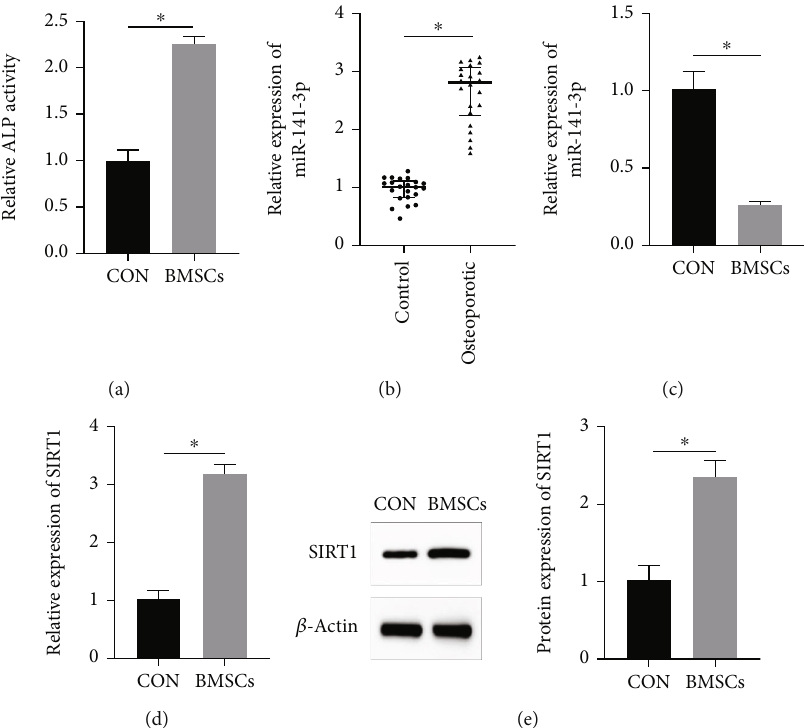
Figure 1: miR-141-3p was downregulated during osteogenic di ff erentiation. (a) ALP activities were evaluated by spectrophotometry. (b, c) The miR-141-3p expression in osteoporotic samples (b) and BMSC-induced osteogenic di ff erentiation (c) was measured via RT-qPCR. (d) The mRNA expression of SIRT1 was evaluated. (e) Protein expression of SIRT1 was examined using western blot. ∗ P < 0 : 05